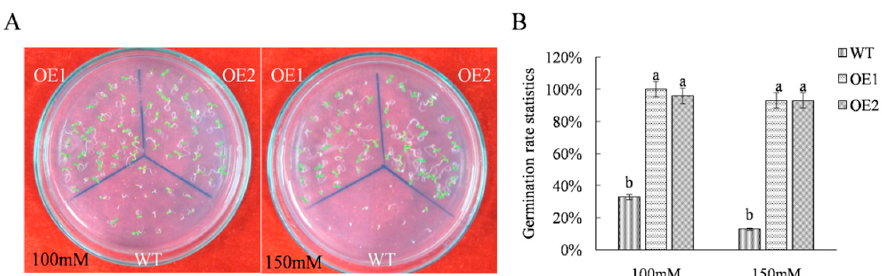
Figure 1. Determination of germination rates of wild-type and transgenic Arabidopsis thaliana under NaCl stress. ( A ) Phenotypic observation of wild-type (WT) and transgenic lines under different NaCl stress. ( B ) Statistics of germination rate of WT and transgenic ThTrx5 Arabidopsis seeds under NaCl stress. Three biological replicates were analyzed. Error bars show the average ± standard deviation of wild-type and transgenic lines (OE1, OE2). Different lowercase letters indicate significant differences ( p ≤ 0.05 from a Student’s t test). WT was Columbia-0 wild-type Arabidopsis thaliana ; OE1, OE2 was ThTrx5 -Overexpressing Transgenic Lines.